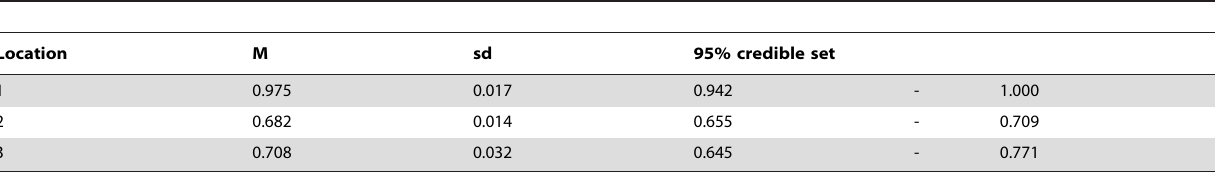
Table 5. Estimated proportion of self-recruits (m; i.e., the proportion of individuals estimated to have originated within the population) in each of the three Texas population samples, as estimated by the program B AYES A SS